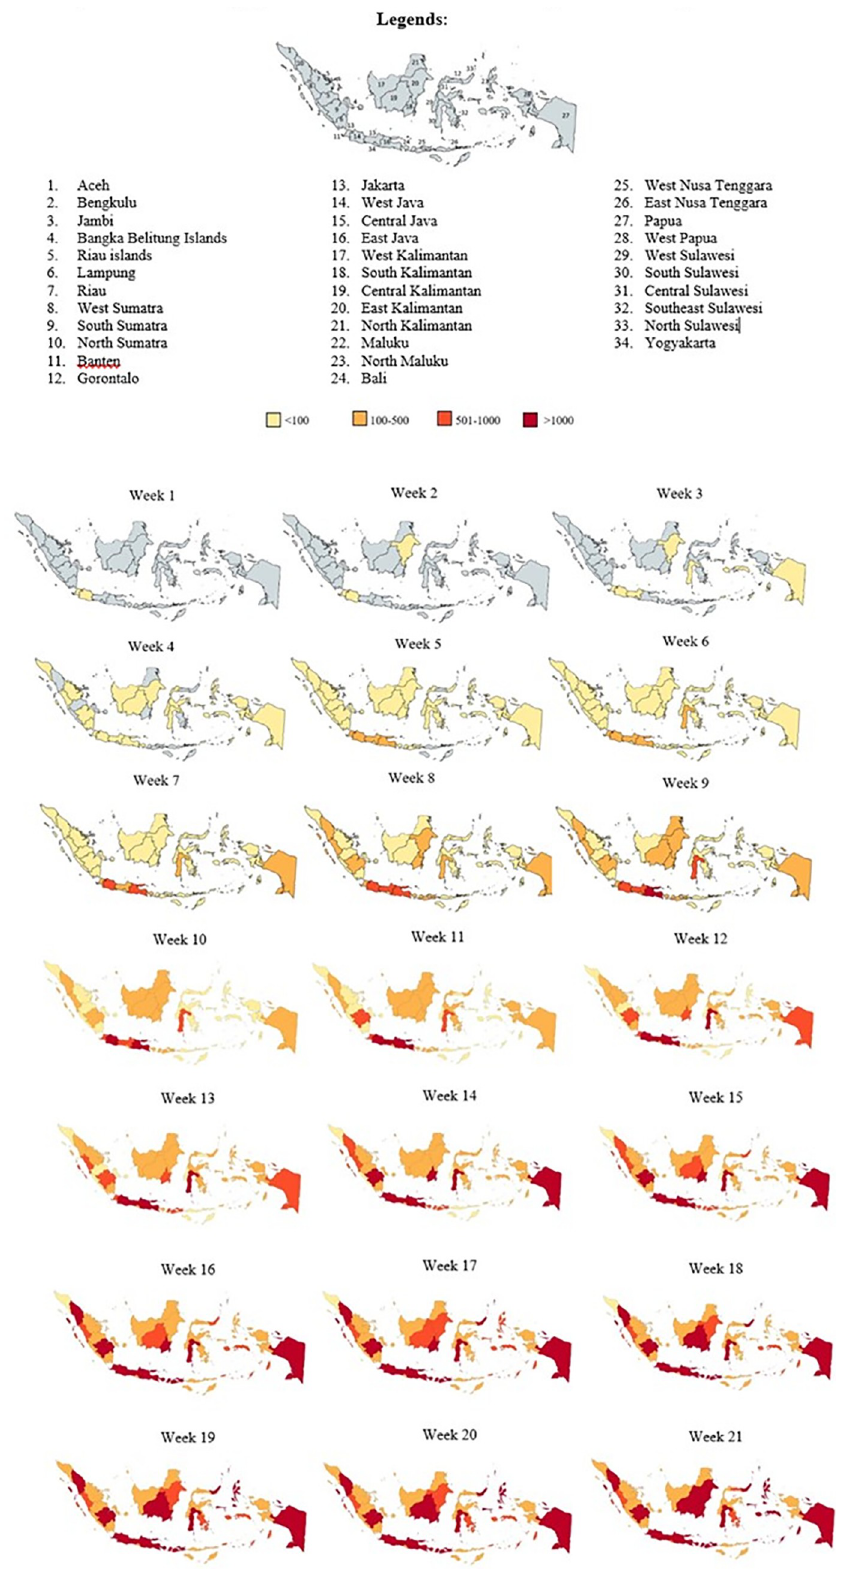
Fig 3. Distribution map of Covid-19 cumulative cases in Indonesia from March 2 nd –August 2 nd 2020.